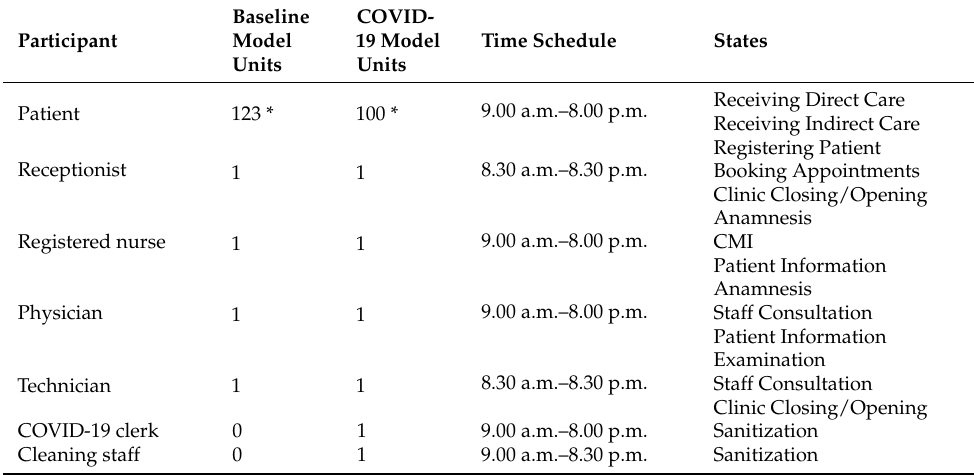
Table 1. Volumes, calendar and states of the process participants.